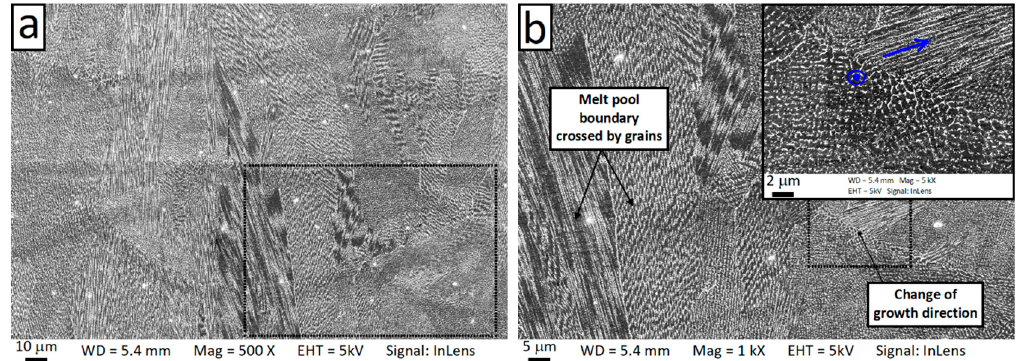
Figure 11. Scanning electron microscopy (SEM) micrographs of the vertical plane showing the columnar dendrites crossing melt pool boundaries ( a ) and the change of dendrite direction at the melt pool boundary ( b ). Blue arrows in ( b ) indicate the growth direction of the dendrites.